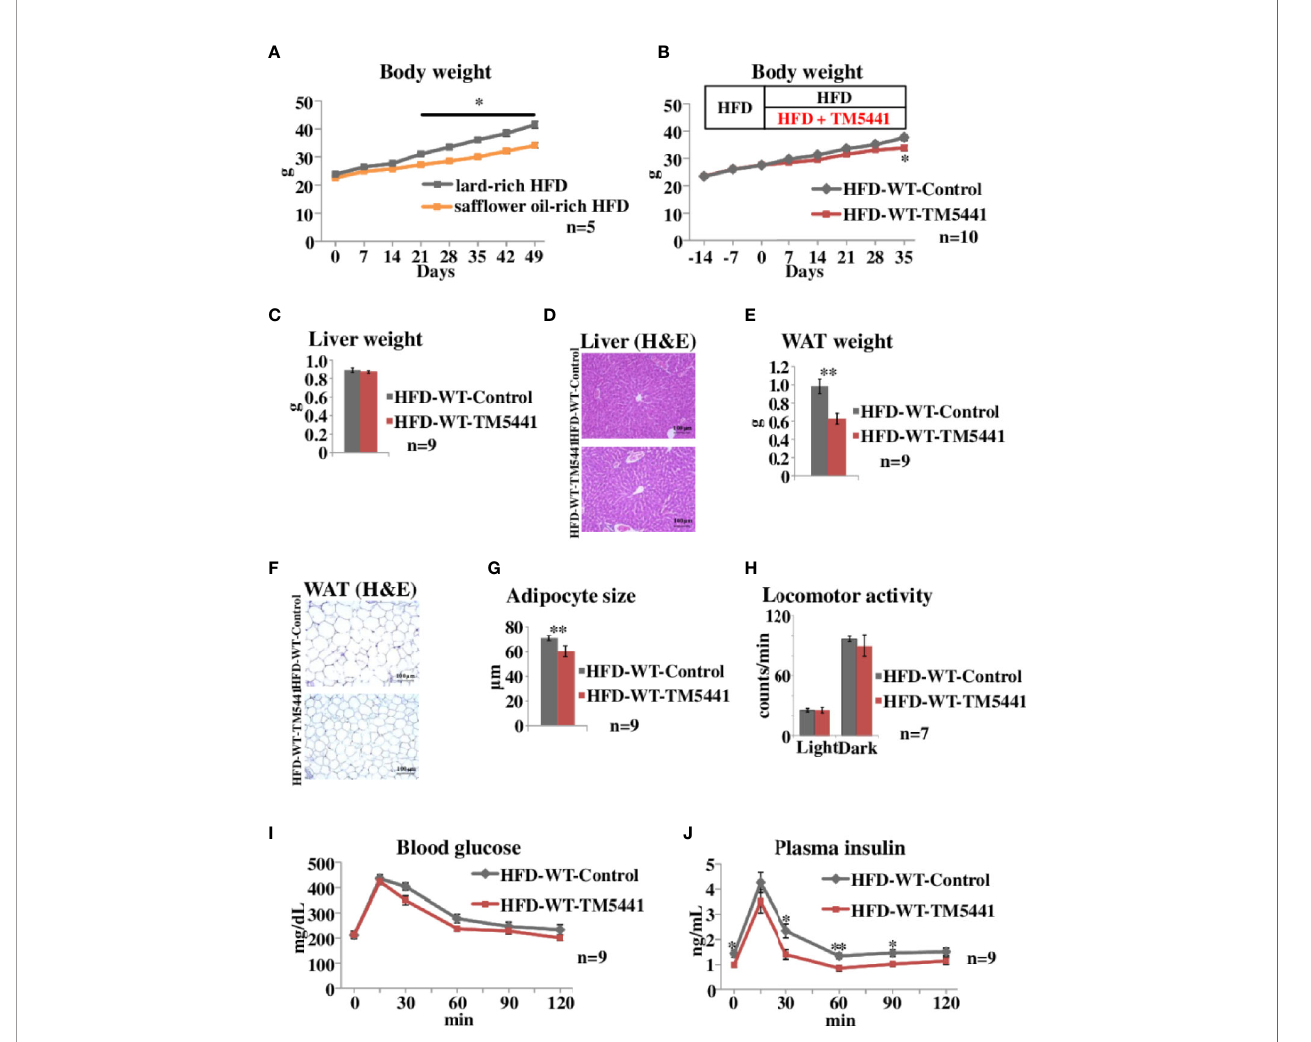
FIGURE 2 | Body weight and oral glucose tolerance tests in lard-rich HFD fed mice treated with TM5441. (A) Body weight of WT mice fed saf fl ower oil-rich HFD or lard-rich HFD. Each bar represents the mean ± SE of n = 5 mice. (B) Body weight of lard-rich HFD-fed mice treated with TM5441. Ten-week-old WT mice that had been pre-fed the lard-rich HFD for 2 weeks were given either lard-rich HFD mixed with TM5441 (HFD-WT-TM5441 mice) or lard-rich HFD (HFD-WT-Control mice) and then were weighed weekly. Each bar represents the mean ± SE of n = 10 mice. (C) Liver weight of HFD-WT-TM5441 and HFD-WT-Control mice. Each bar represents the mean ± SE of n = 9 mice. (D) Representative hematoxylin eosin (HE) staining of liver sections of HFD-WT-TM5441 and HFD-WT-Control mice (original magni fi cation: 20×, scale bars: 100 m m). (E) Epididymal white adipose tissue (WAT) weight of HFD-WT-TM5441 and HFD-WT-Control mice. Each bar represents the mean ± SE of n = 9 mice. (F) Representative HE staining of WAT sections of HFD-WT-TM5441 and HFD-WT-Control mice (original magni fi cation: 20×, scale bars: 100 m m). (G) Adipocyte size of HFD-WT-TM5441 and HFD-WT-Control mice. Each bar represents the mean ± SE of n = 9 mice. (H) Locomotor activities of HFD- WT-TM5441 and HFD-WT-Control mice during light hours and dark hours. Each bar represents the mean ± SE of n = 7 mice. (I) Blood glucose levels and (J) plasma insulin levels during oral glucose tolerance tests performed 35 days after the initiation of lard-rich HFD feeding. Results are expressed as mean ± SE of n = 9 mice. * P < 0.05 and ** P <